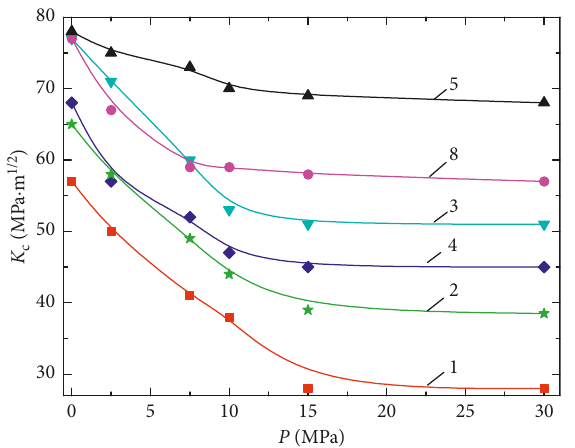
Figure 3: Dependences of plasticity characteristics δ (1–3) and ψ (4–6) of prehydrogenated (623 K, 30MPa H 2 , 10h) specimens in hydrogen under pressure 30MPa on the strain rate: 1, 4: CC (I) VAR, HT III; 2, 5: CC (I) VAR, HT II; 3, 6: CC II, VAR, HT II.